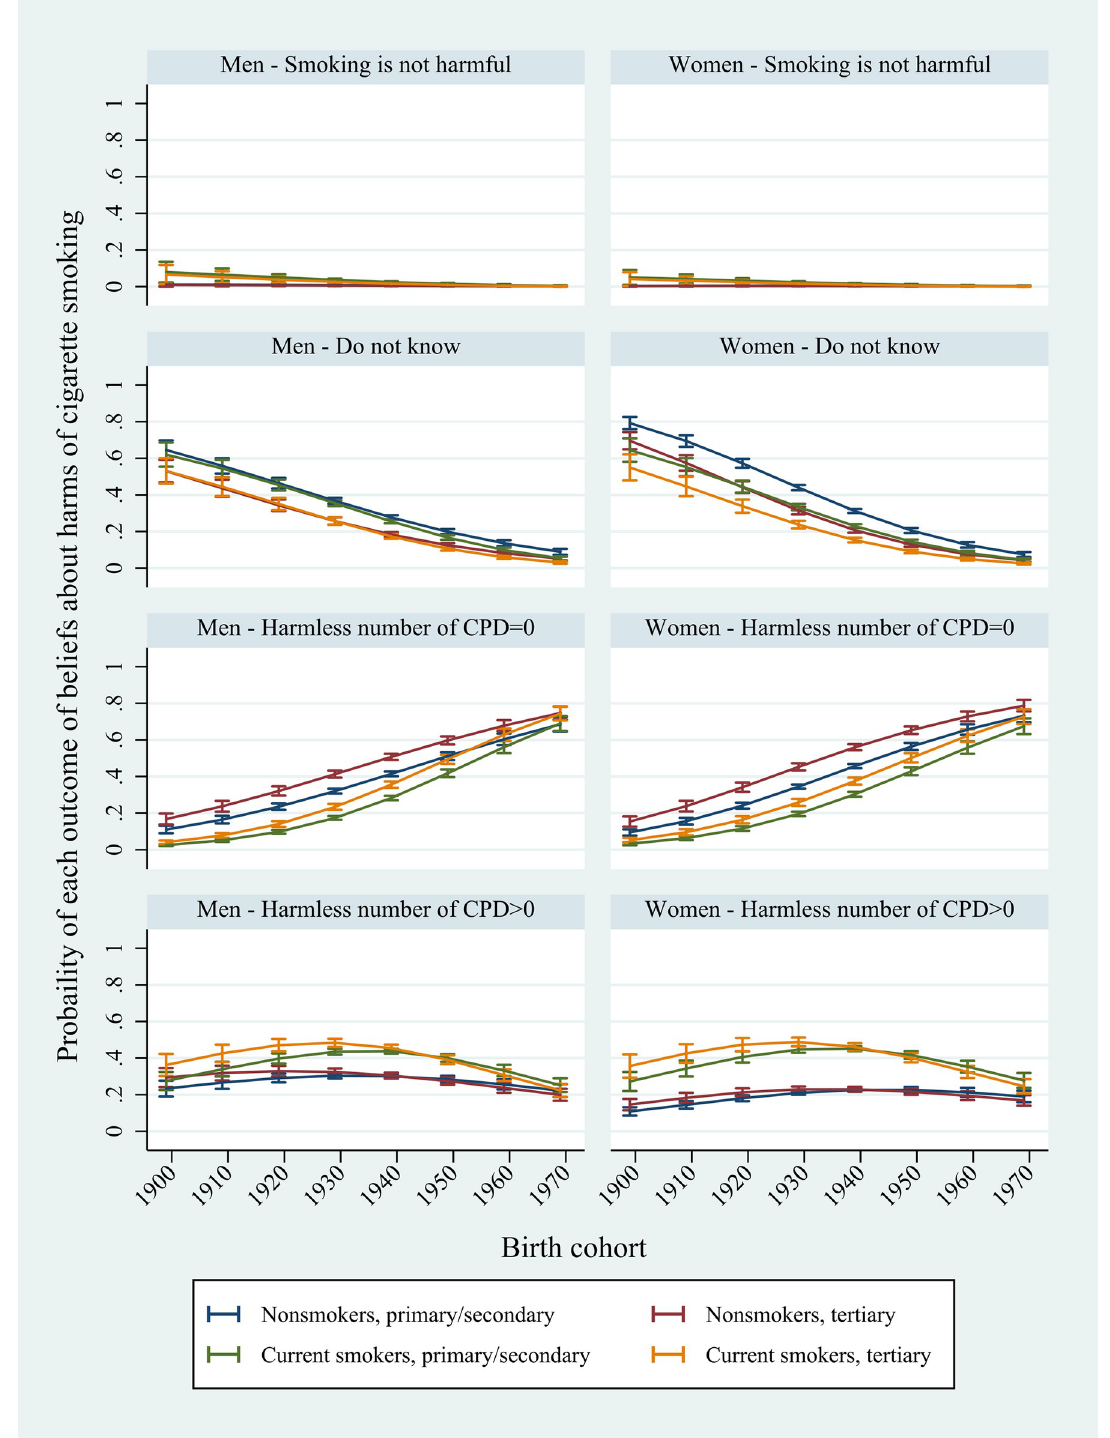
Fig 1. Adjusted predicted probabilities of i) believing that smoking is not harmful, ii) not knowing the safe number of CPD, iii) believing that the harmless number of CPD is zero and iv) believing that the harmless number of CPD is above zero. Male and female smokers and non-smokers with primary/secondary or tertiary education born in the period 1899 to 1969 (Model H6_1).